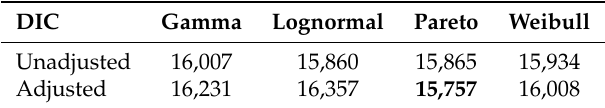
Table 2. Model selection based on deviance information criterion (DIC) criteria for Bayesian hierarchical